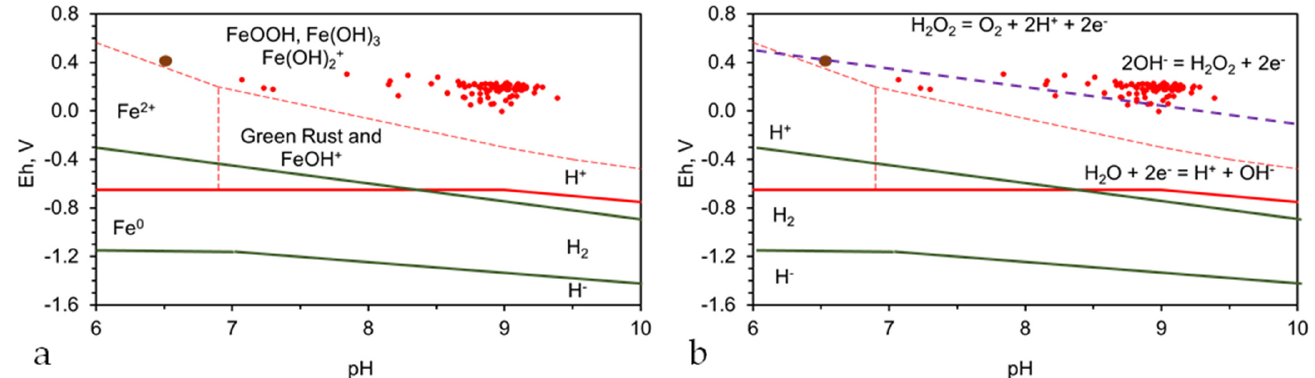
Figure A10. Redox Regimes. ( a ), The main redox regimes associated with ZVI water remediation. Red solid and dashed lines represent the equilibrium outcome redox fences. Green lines indicate the redox fences for Hydrogen Stability Zones 0, 1, 2. Brown dot is the example fresh water composition. ( b ), redox regimes showing H 2 O 2 Redox boundary (purple dashed line); red dots are product water outcomes over an 1850 h period, where a cumulative total of 237 m 3 water is flowed continuously through a 0.5 kg particulate m-Fe 0 bed.